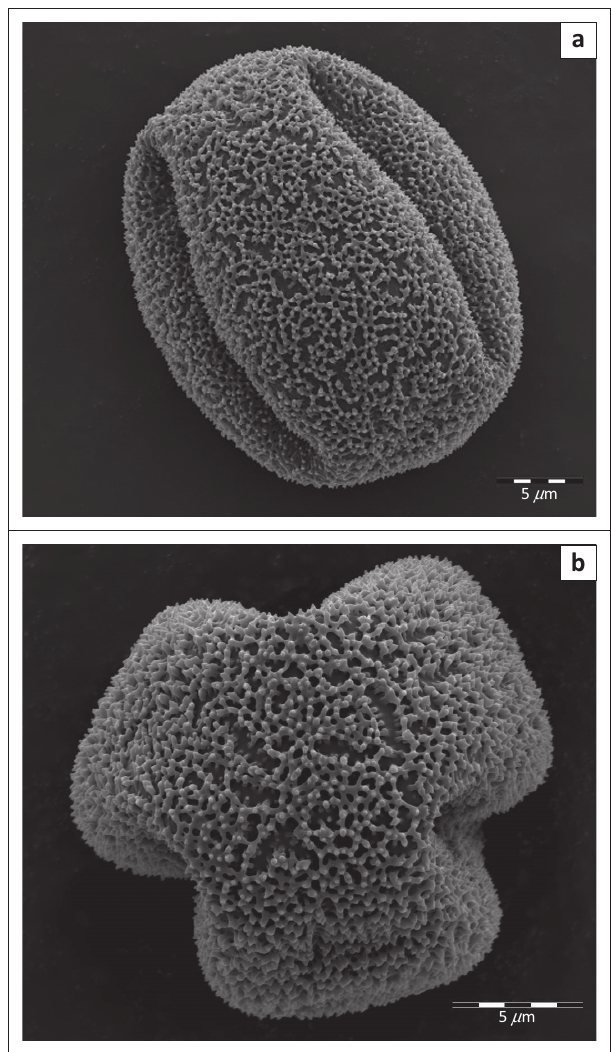
Source : Photo courtesy of K. Smit. FIGURE 1: Frithia humilis plants in flower (a) and displaying a fresh (left) and an expired flower (right) on the same plant